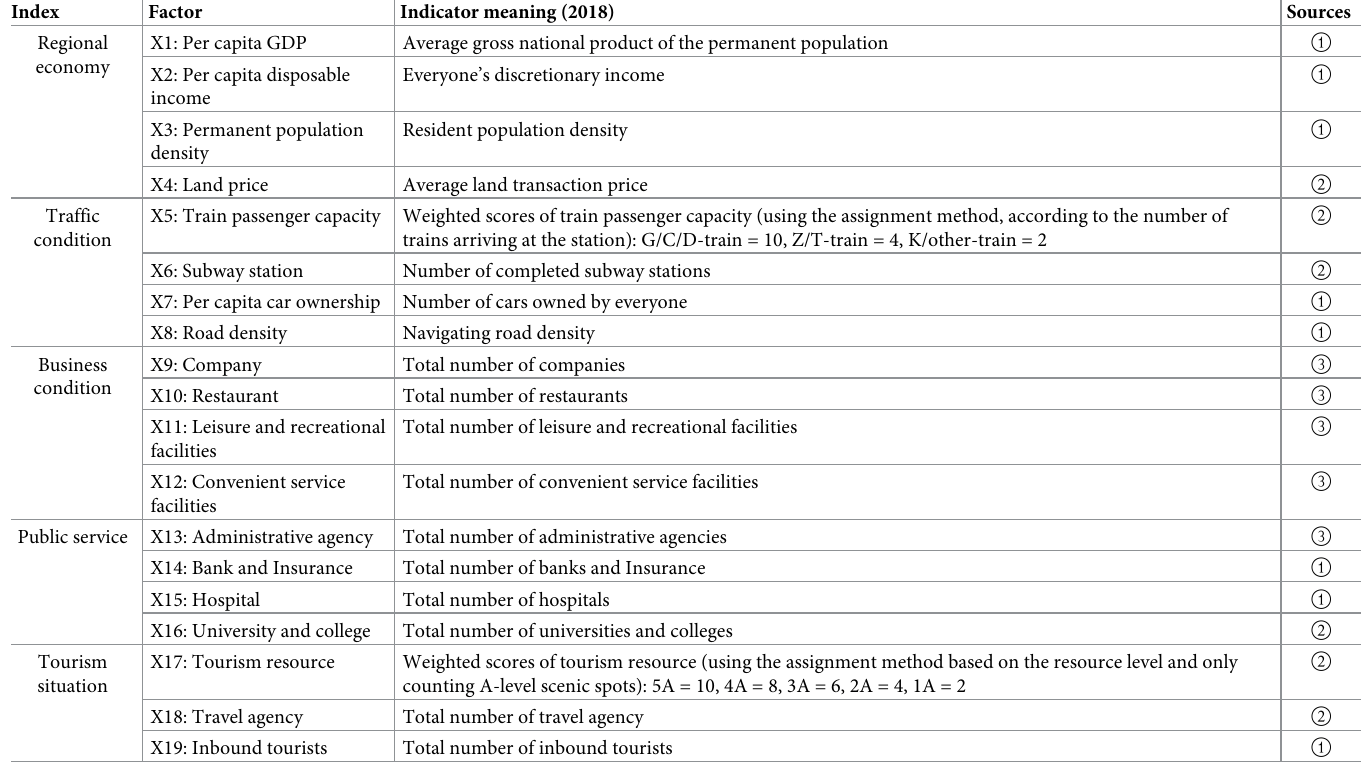
Table 3. The factors of hotels’ spatial distribution in